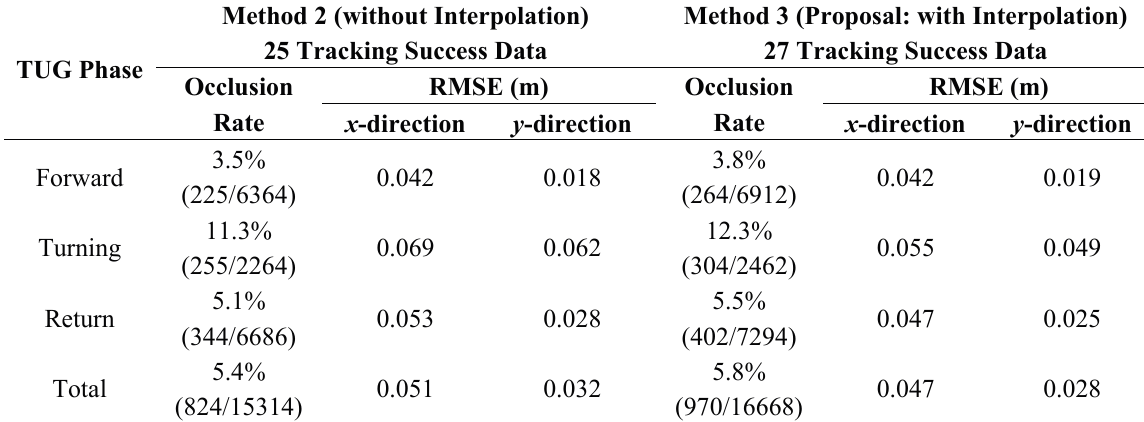
Table 4. Occlusion rate and RMSE of the leg trajectory in each TUG phase of the tracking success data of Methods 2 and 3.